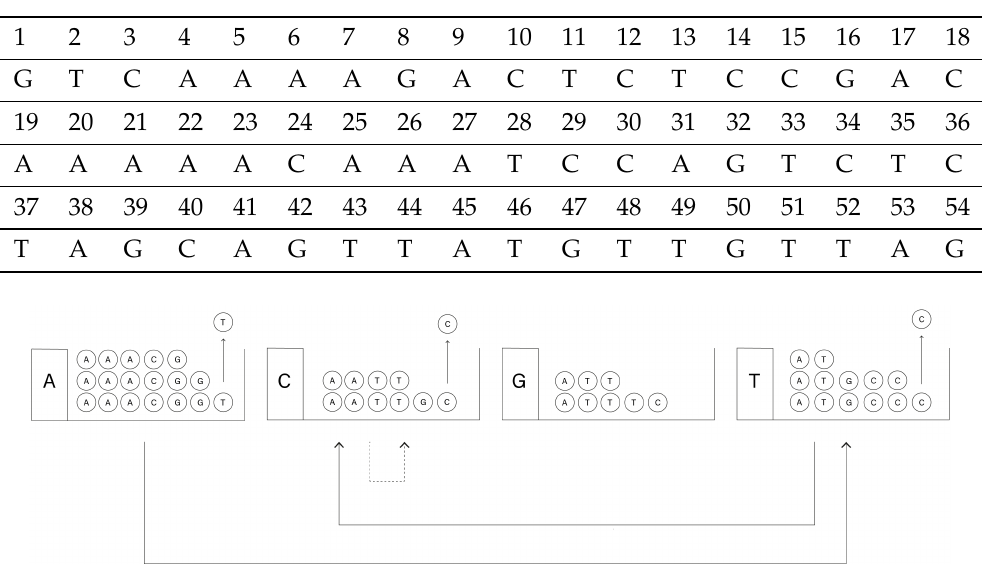
Table 4. Numbered 54-base-pair-long segment of SATB1.